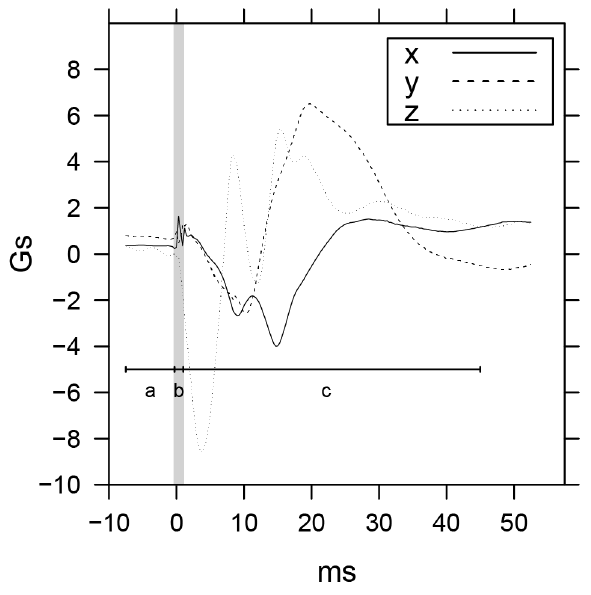
Figure 2. Sample Averaged Gunshots with Feature Windows. Tri-axis accelerometer readings for 359 aligned and averaged gunshots. Windows for the calculation of statistical features cover the period from 2 7.5 ms pre-spike to 45 ms post-spike. Window (a) covers the pre-spike period from 2 7.5 ms to 2 0.3 ms, window (b) covers the spike period from 2 0.3 ms to 1 ms, and window (c) covers 1 ms to 45